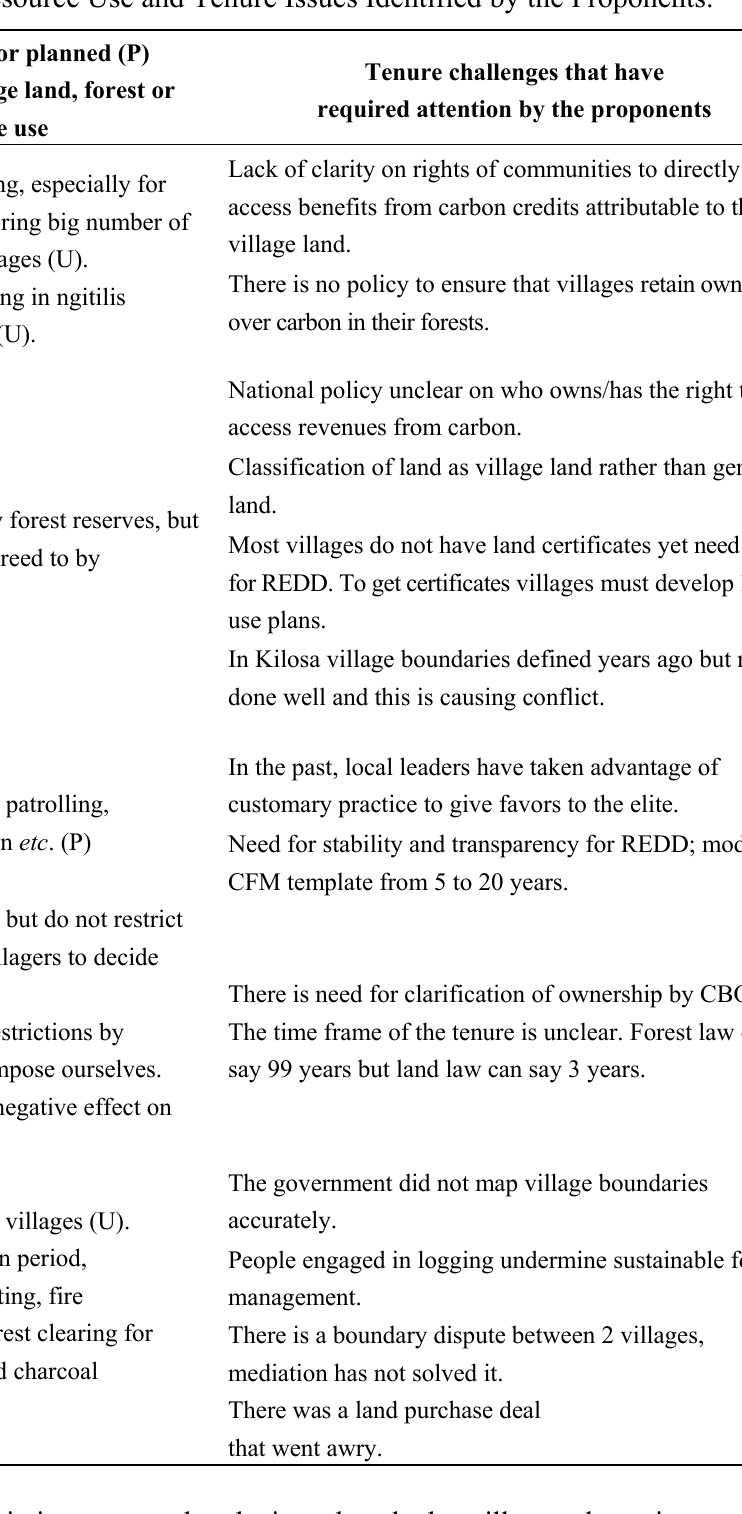
Table 4. Changes in Resource Use and Tenure Issues Identified by the